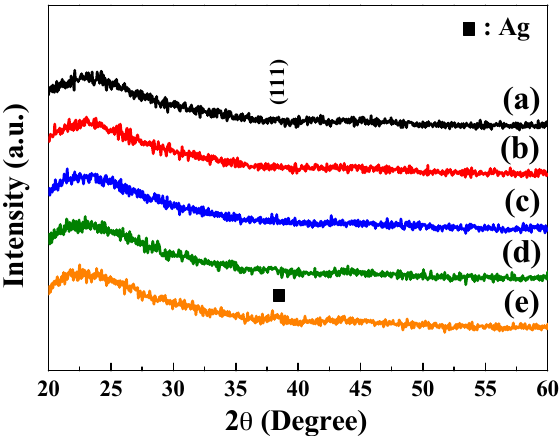
Figure 2. XRD analysis of the α -IGZO/Ag/ α -IGZO triple-layer structures as a function of thickness of Ag film. ( a ) 10; ( b ) 11.5; ( c ) 13; ( d ) 14.5; and ( e ) 16 nm, respectively.